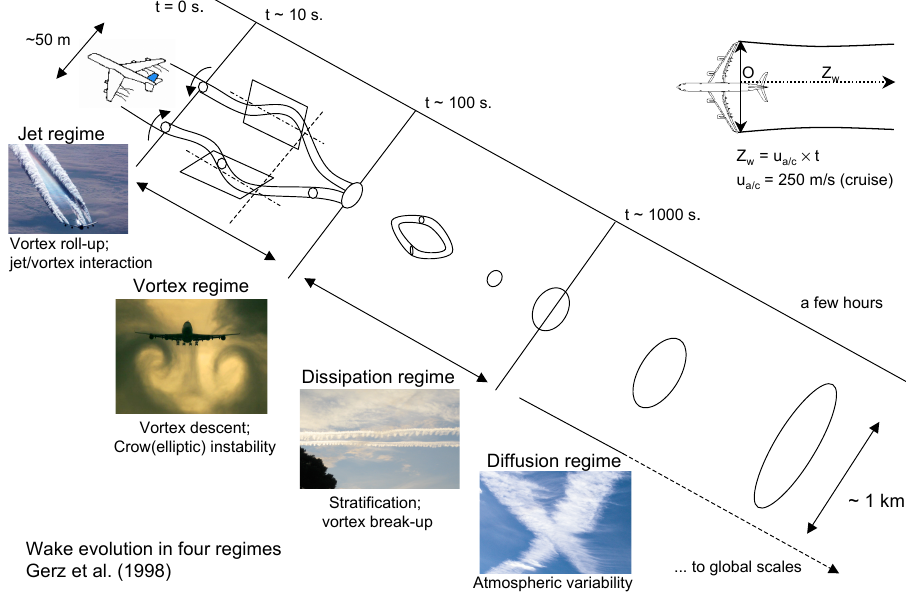
Fig. 1. Sketch of aircraft plume evolution according to the classification of aircraft wakes in four regimes (Paoli,